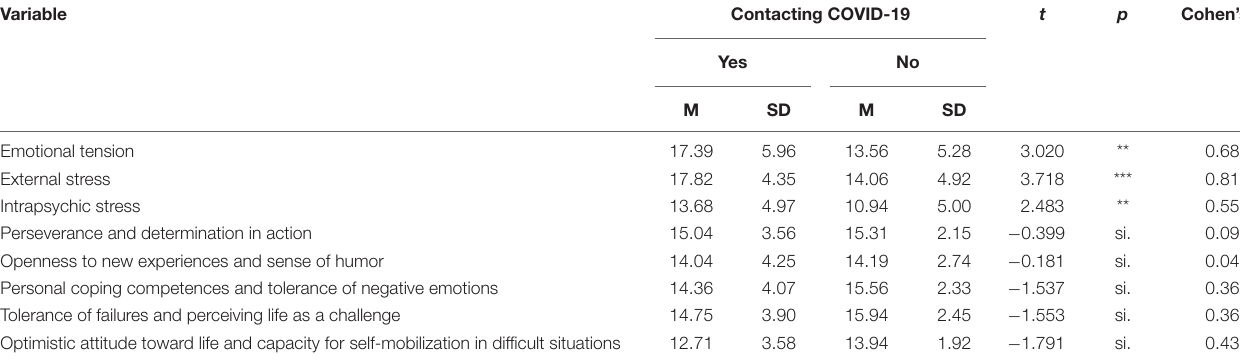
TABLE 3 | Stress and resilience levels among paramedics who had ( N = 52) and did not have ( N = 32) contact with patients with COVID-19.